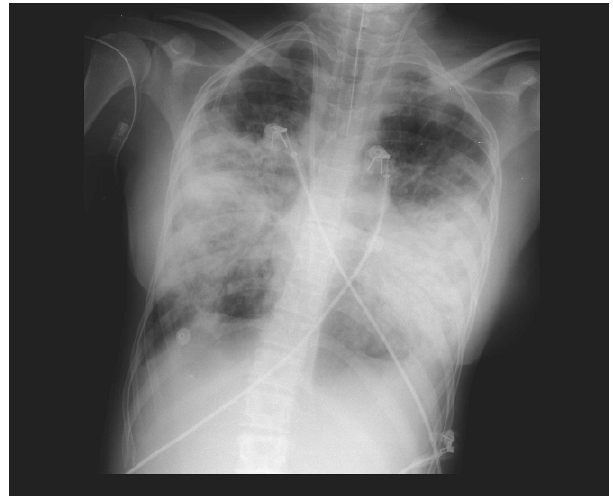
Figure 1 - Chest X-ray before the installation of